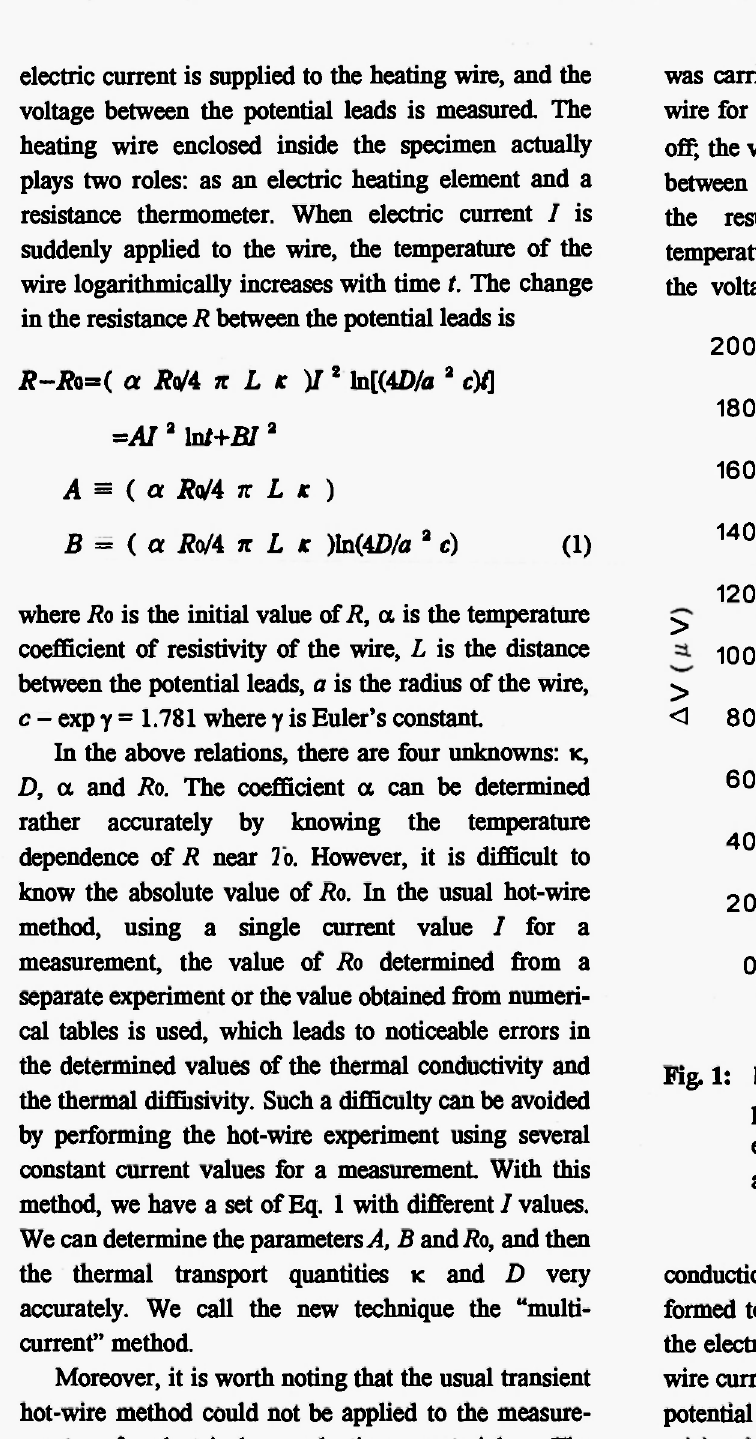
Fig. 1: V vs t data showing relaxation of ionic polarization at potential leads for water, electrolyte solution, and ionic conducting glass at lower and higher